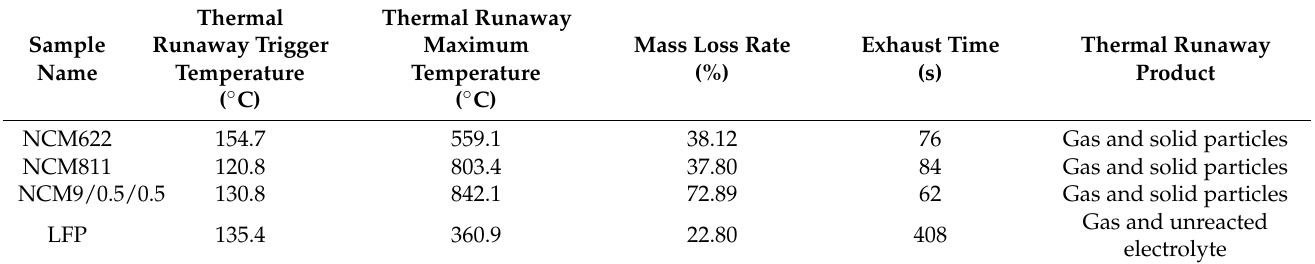
Table 2. Key parameters of four